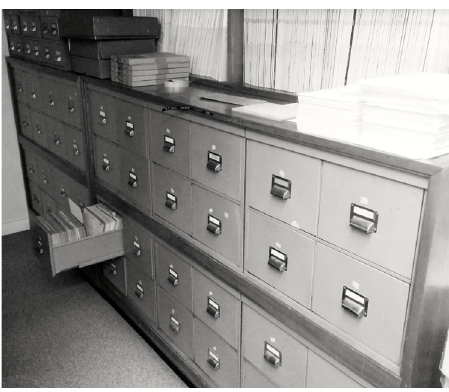
Fig. 3: The National Bronze Implements